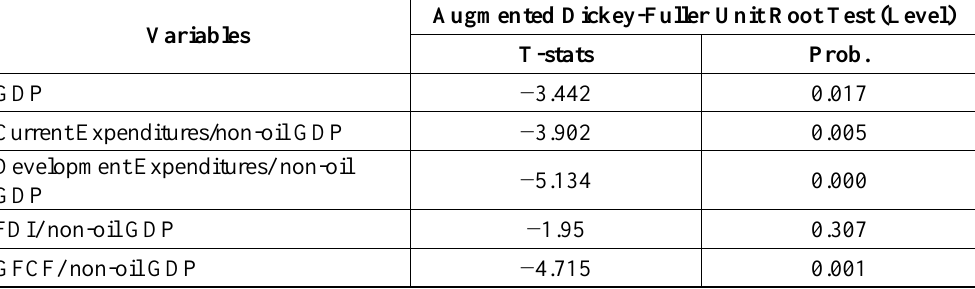
Table 1. Results of ADF Unit Root Test (at level specification)